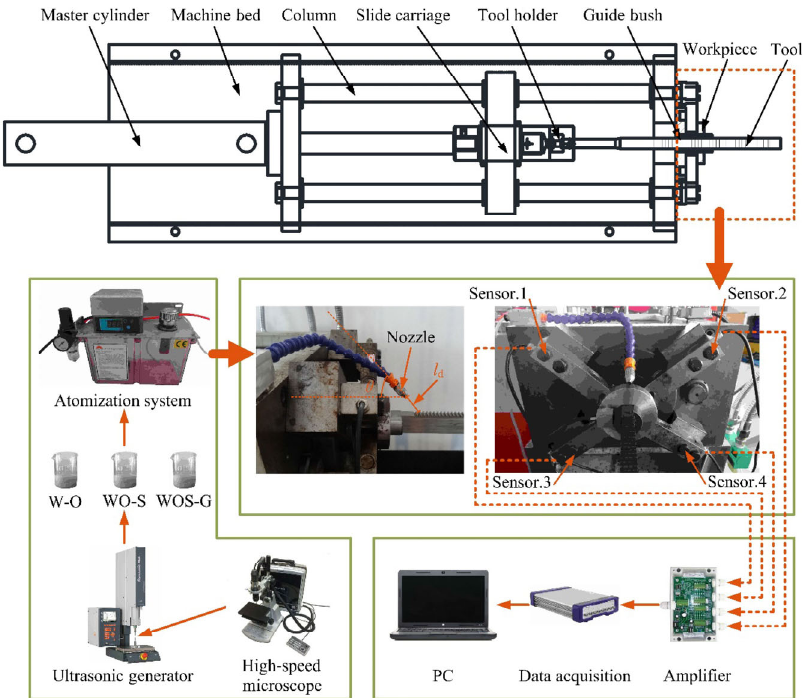
Fig. 1 Experimental setup for